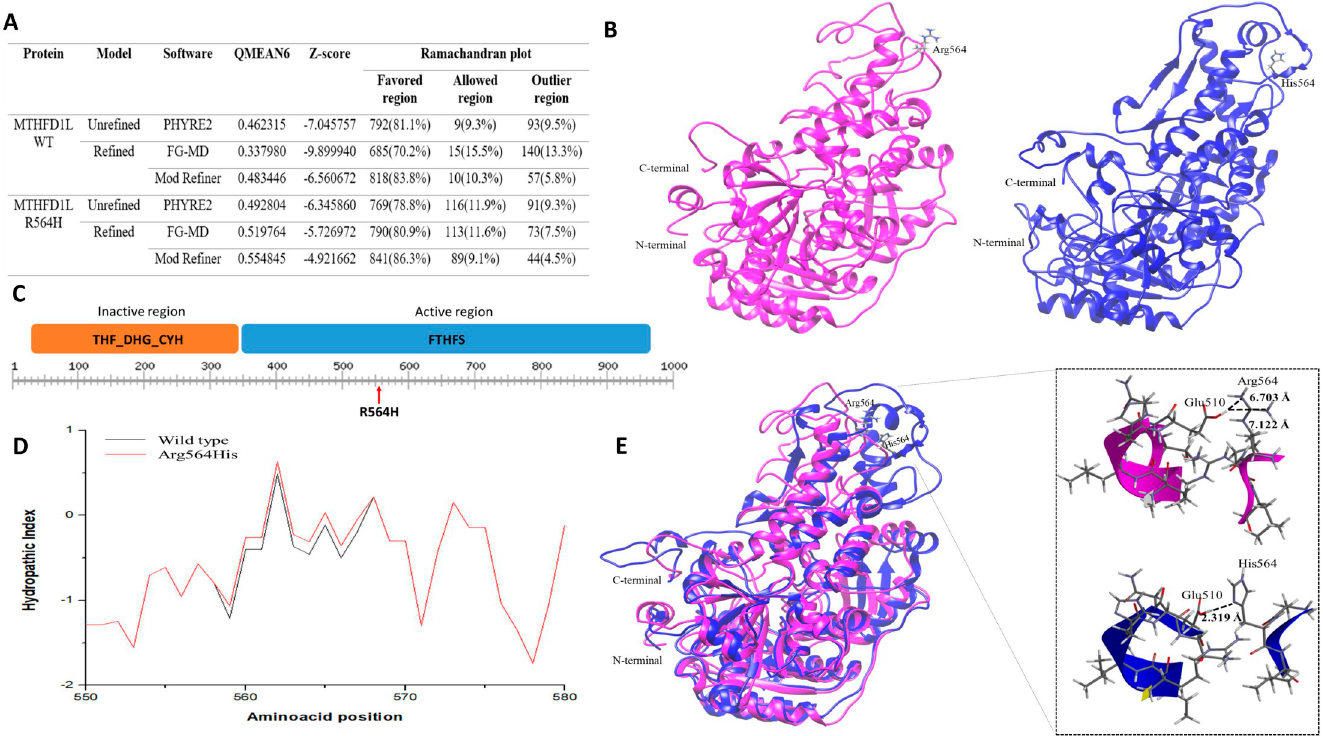
Fig 4. MTHFD1L structural model. A . Energy and stereochemistry validation of structural models of MTHFD1L protein. B . Structural model of MTHFD1L protein with UCSF Chimera software: Hypothetical model of the wild type of enzyme (magenta) and Arg564His variant (Blue). C . Domains of MTHFD1L. THF_DHG_CYH: N-terminal inactive methylene-THF dehydrogenase and cyclohydrolase domain. FTHFS: Active larger formyl-THF synthetase C-terminal domain. D . Hydropathic index. Black: Wild type, Arginine at position 564 of the MTHFD1L protein. Red.: R564H, Histidine at position 564 of the MTHFD1L protein. E . 3D alignment of the MTHFD1L enzyme: Hypothetical model of the wild type of enzyme (magenta) and Arg564His variant (Blue). Three-dimensional representation of the fragments in secondary structure for ribbons and sticks: Above (magenta) fragment for the wild type of enzyme at position Arg564; Bottom (Blue) fragment for the His564 variant.